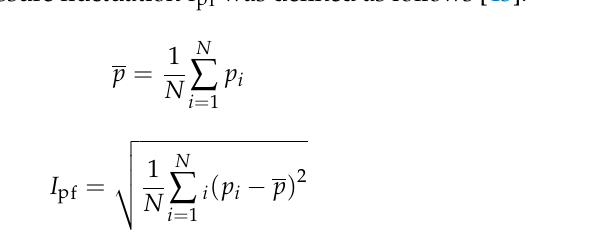
Figure 19. Schematic diagram of pressure pulsation monitoring points’ setting positions (r* = 0.98). The obtained pressure coefficient curves are shown in Figure 20, and the dotted line in the figure is the average value of the pressure coefficient. As shown in Figure 20a, the pressure coefficient of H31/H32 remained the lowest value, indicating that a large amount of cavitation was generated and grew steadily, and the pressure began to pulsate at H33, indicating that the height was the cavitation bound- ary area, where the cavitation bubble seemed to experience a small rupture.